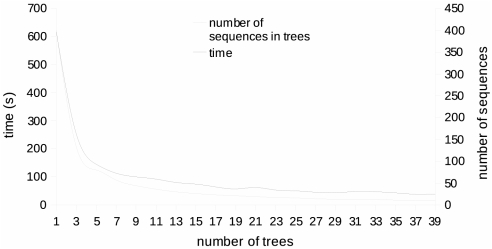
JET computational time.JET computational time (in seconds) has been evaluated for 400 sequences
homologous with that of Escherichia coli aspartate
transcarbamoylase 9atc:A. Each of the  trees used contains  sequences, as indicated by the curve “number
of sequences in trees”. For the evaluation, we used a Dual
Intel Xeon (64-bit) 3.2GHz 2GB memory with Linux system.